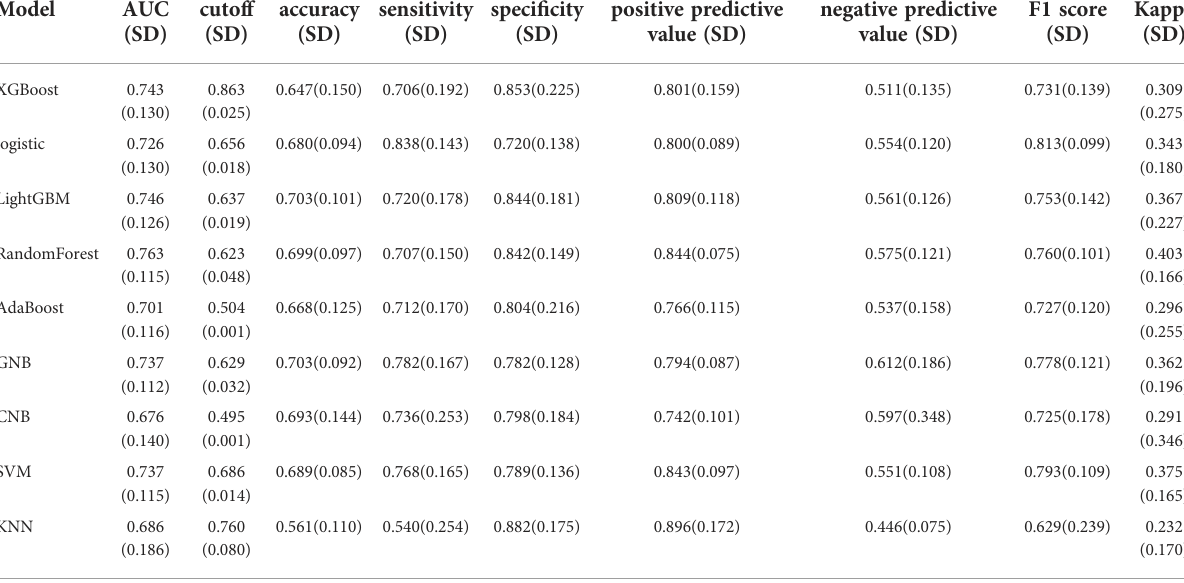
TABLE 2 Multi-model comparison, validation set results.